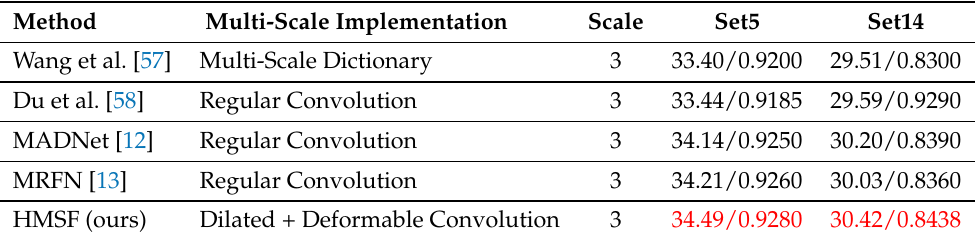
Figure 13. Diagram analysis of model memory consumption and performance. The proposed model achieves the best performance with less memory consumption. Table 10. Quantitative comparisons (PSNR (DB)/SSIM for 3 × ) of SOTA multi-scale-based SR models. Red text means the best